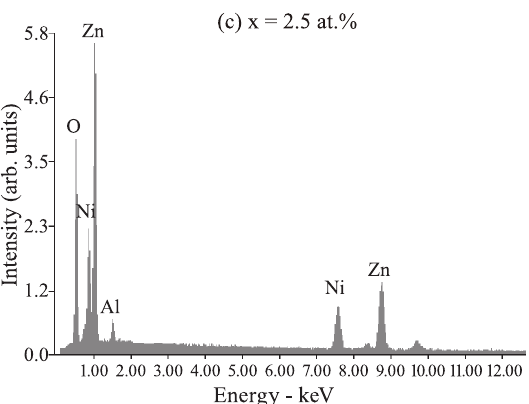
Table 2 . The average crystallite sizes range from 39 to 53 nm. The slight changes in the lattice parameters ( Table 3 ) are expected due to the ionic radii mismatch. Both ionic radii of Al 3+ (0.57 Å) and Ni 2+ (0.69 Å) are